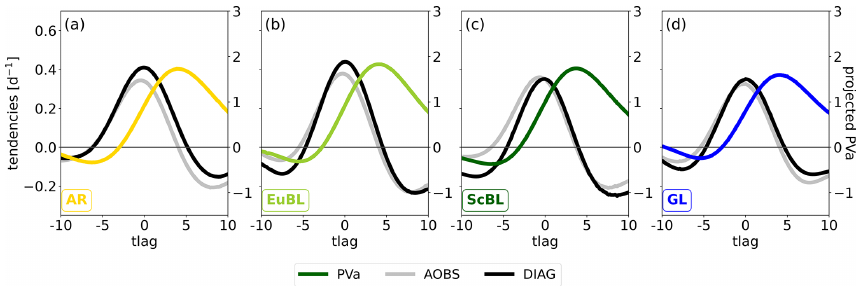
Figure 2. Projections onto the respective regime pattern of PV anomalies (colored, right y axis), the associated observed tendency (grey, left y axis), and the diagnosed tendency (black, left y axis) shown ± 10d around onset: (a) AR, (b) EuBL, (c) ScBL, and (d) GL.